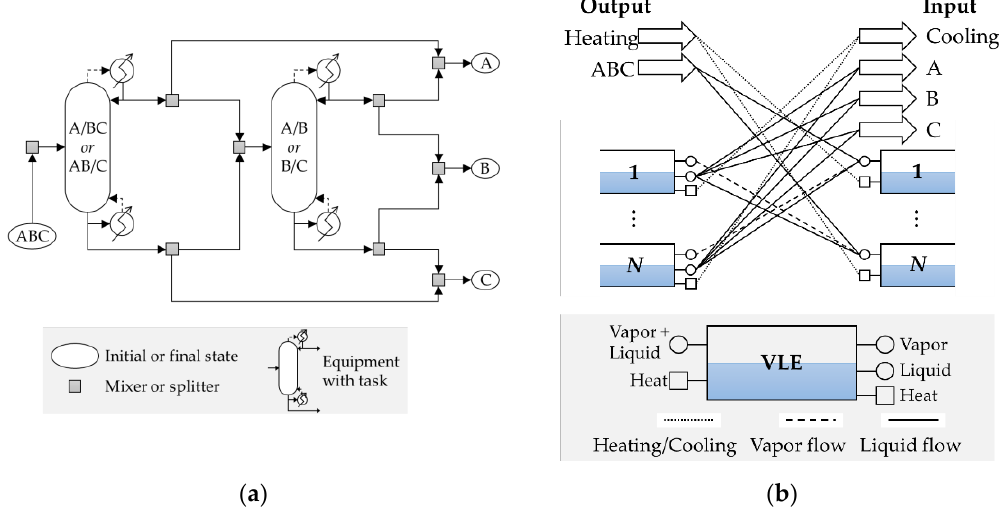
Figure 2. Synthesis problems for the separation of a ternary mixture: ( a ) high aggregation; ( b ) low